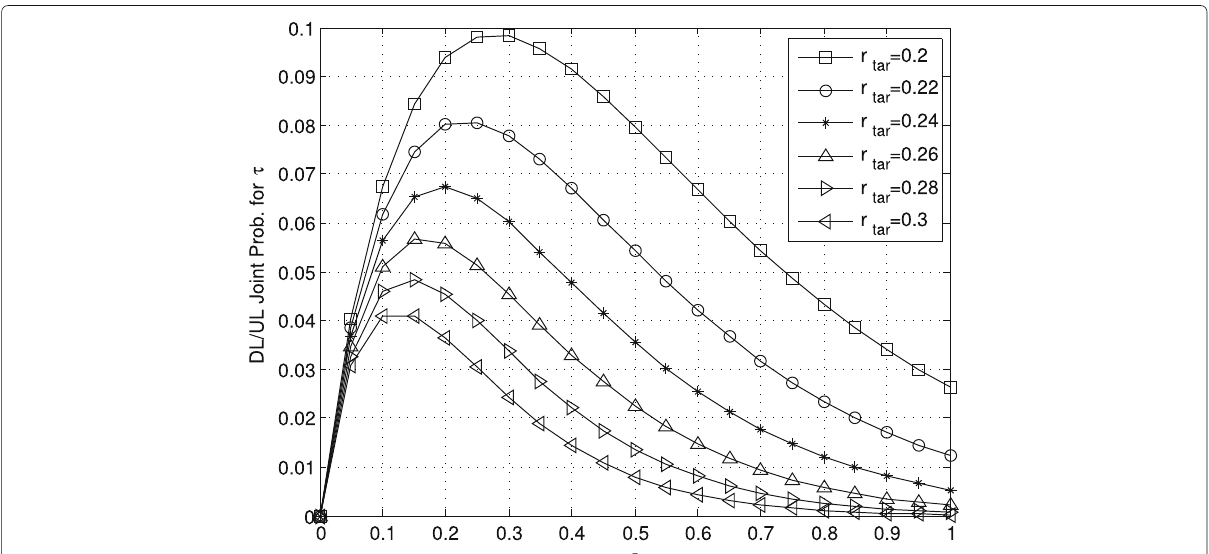
Fig. 3 DL/UL joint probability for varying TP with different target distance when T d (dB) = − 10 and T u (dB) = 0. It is shown that there are optimal TPs to maximize the DL/UL joint probability